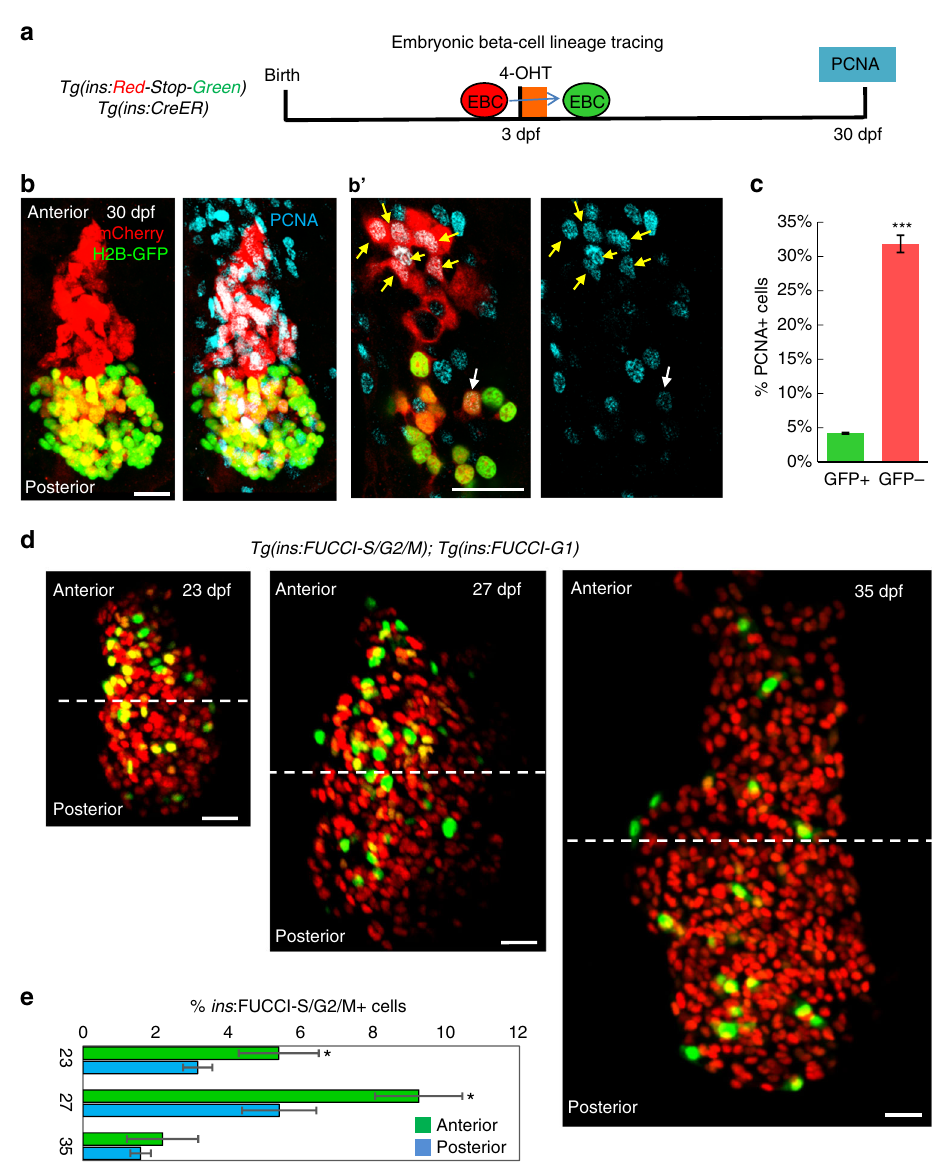
Fig. 6 Beta-cells differentiating from post-embryonic progenitors are more proliferative compared to the embryonic beta-cells. a Schematic showing the labeling of the embryonic beta-cell ( EBC ) population during growth. Tg(ins:Cre-ER T2 ) — mediated recombination excises the fl oxed mCherry from Tg(ins:Red- Stop-Green) . Beta-cells that undergo successful recombination activate insulin:H2B-GFP expression. Recombination was induced using a 4-OHT treatment at 3 dpf. New beta-cells that differentiate post-recombination are GFP-negative and can only express mCherry. The samples were stained at 30 dpf using an antibody for PCNA, which peaks in expression during the G1/S-stages of the cell cycle. b Confocal projections of islets from Tg(ins:Cre-ER T2 );Tg(ins:Red-Stop-Green) animals at 30 dpf. The GFP-positive beta-cells localize preferentially in the posterior half of the islet, whereas the anterior half is occupied by GFP-negative but mCherry-positive beta-cells. b ′ Higher magni fi cation single planes from the cells shown in b . A majority of the mCherry-positive but GFP-negative beta-cells are also PCNA-positive ( yellow arrows ) whereas only one of the GFP-positive beta-cells is PCNA-positive ( white arrows ). Note that since Tg(ins:Red-Stop-Green) contains multiple cassettes within one genomic integration site, some of the beta-cells are both GFP and mCherry-positive due to incomplete excision of mCherry in all cassettes during the 4-OHT treatment. c Quanti fi cation showing that a higher proportion of GFP-negative beta-cells were PCNA-positive at 30 dpf compared to the GFP-positive beta-cells, indicating higher proliferative capacity of de novo beta- cells during islet growth ( n > 50 GFP-positive and -negative cells per islet, n = 7 islets) (unpaired two-tailed t -test, *** p < 0.005). Plot shows mean ± S.E.M. d Confocal projections of islets from Tg(ins:FUCCI-G1); Tg(ins:FUCCI-S/G2/M) animals at 23, 27, and 35 dpf oriented along the anterior – posterior axis. Samples were collected ~10 h after feeding, which is important to stimulate beta-cell proliferation during the late larval and juvenile stages in zebra fi sh 33 . e Quanti fi cation of the percentage of Tg(ins: FUCCI-S/G2/M )- positive and Tg(ins: FUCCI-G1 )- negative beta-cells in the anterior and posterior halves of islets from each stage. At 23 and 27 dpf, a higher proportion of proliferating beta-cells are present in the islet ’ s anterior half, as compared to the posterior. At 35 dpf, beta-cell proliferation is similar in both the anterior and the posterior regions. In addition, beta-cell proliferation is reduced compared to 23 and 27 dpf ( n = 8 islets at 23 dpf; n = 5 islets each at 27 and 35 dpf) (paired two-tailed t -test, * p < 0.05). Scale bars , 20 µ